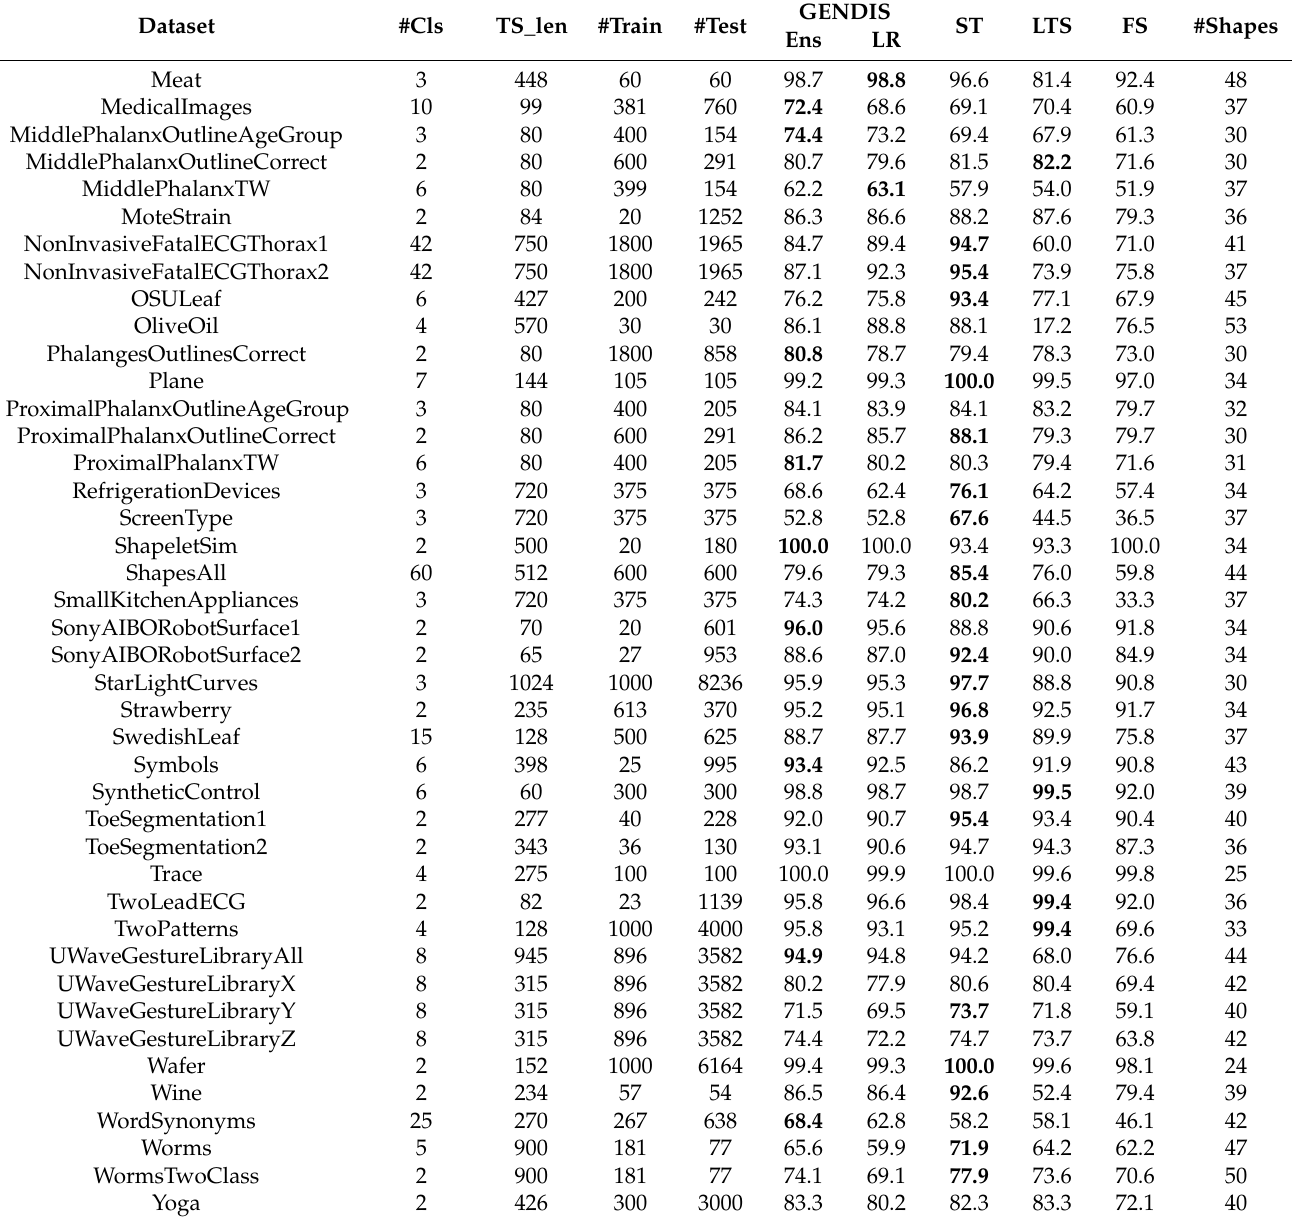
Table 3. A comparison between gendis and three other shapelet techniques on 85 datasets. ST, Shapelet Transform; LTS,Learning Time Series Shapelets; FS, Fast Shapelets; #Cls = number of Classes; TS_len = length of Time Series; #Train = number of Training time series; #Test = number of Testing time series; #Shapes = number of extracted shapelets by